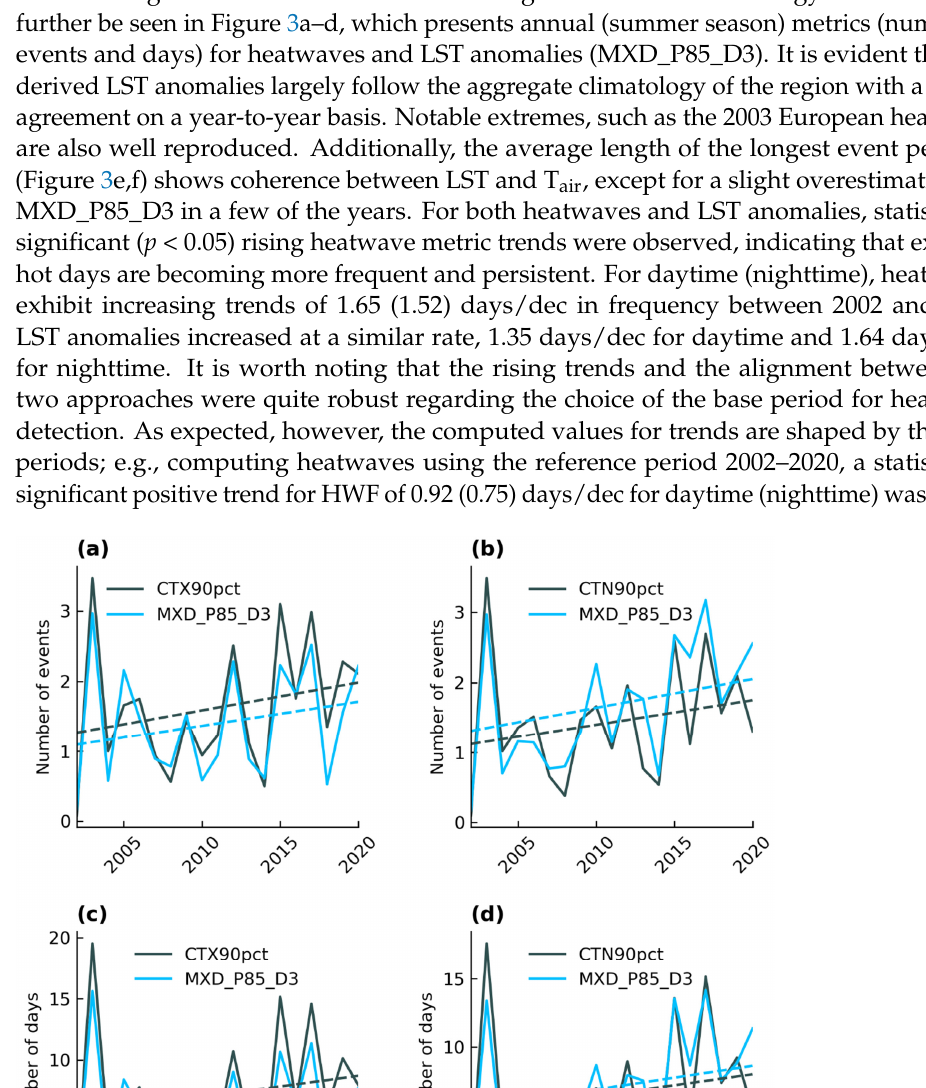
Figure 3. Timeseries of HWN ( a , b ), HWF ( c , d ), and HWD ( e , f ) for summer heatwaves (CTX90pct and CTN90pct) and LST anomalies (MXD_P85_D3) in the Mediterranean region (2002–2020); dashed lines represent trends.